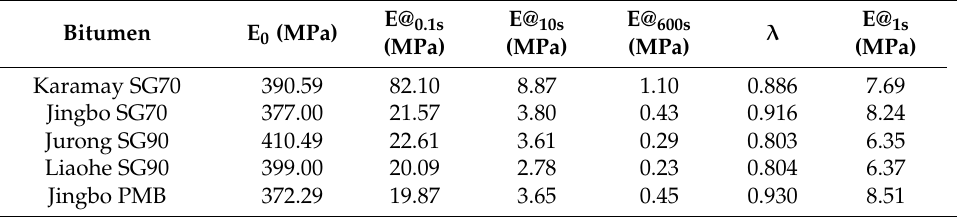
Table 8. Relaxation modulus at some specific times and the fitting results for various bitumen binders at − 25 ◦